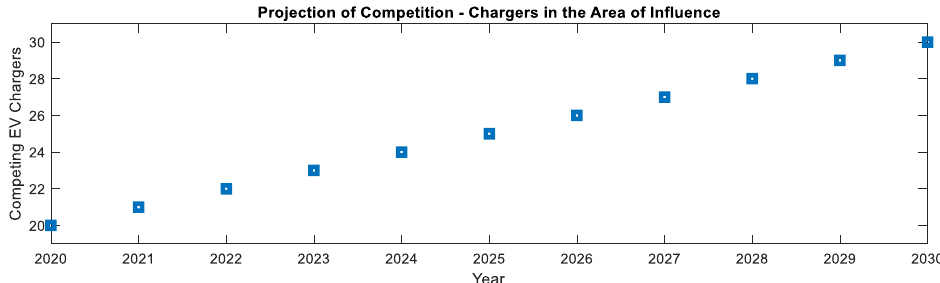
15 of 21 Figure 15. EV Charging Stations in the competition region. Source: Plugshare (Adapted). Thus, in an initial estimate, adopting the premise that the demand for recharge is distributed among the CSs in the competition region, the portion of EVs allocated to the